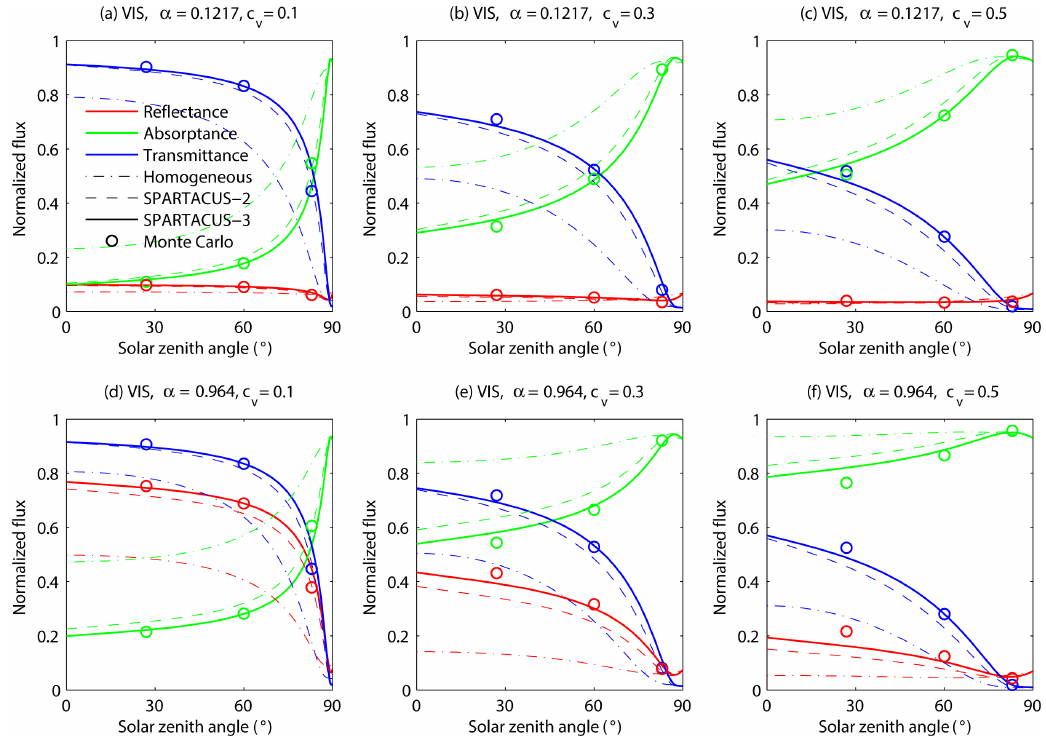
Figure 2. Comparison of normalized irradiances vs. solar zenith angle for the RAMI4PILPS “Open forest canopy” scenario with optical properties appropriate for visible radiation. The two rows of panels show results for different surface albedos ( α ) with the top row using values appropriate for a snow-free surface and the bottom row using values for a snow-covered surface. The columns represent different areal tree fractions ( c v ). The three solid lines depict the reflectance, transmittance and absorptance defined in Eqs. (43), (44) and (45), computed using the three-region version of SPARTACUS. The dashed and dot-dashed lines depict the two-region and one-region SPARTACUS calculations, respectively, where the latter involves complete horizontal homogenization of the vegetation properties through the domain. Also shown are the corresponding Monte Carlo calculations of Widlowski et al. (2011) at solar zenith angles of 27, 60 and 83 ◦ .